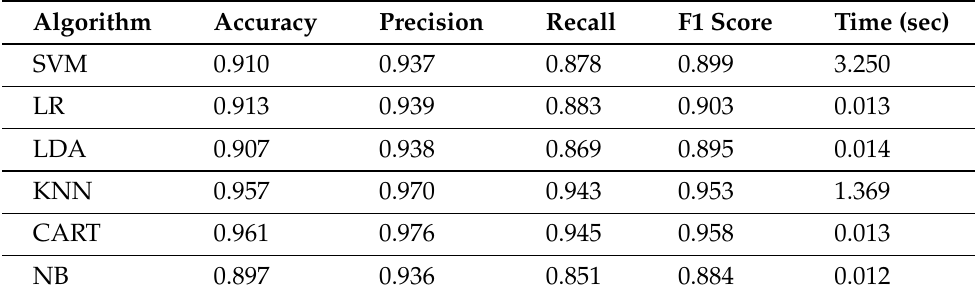
Table 3. Results using the RFE feature selection method.